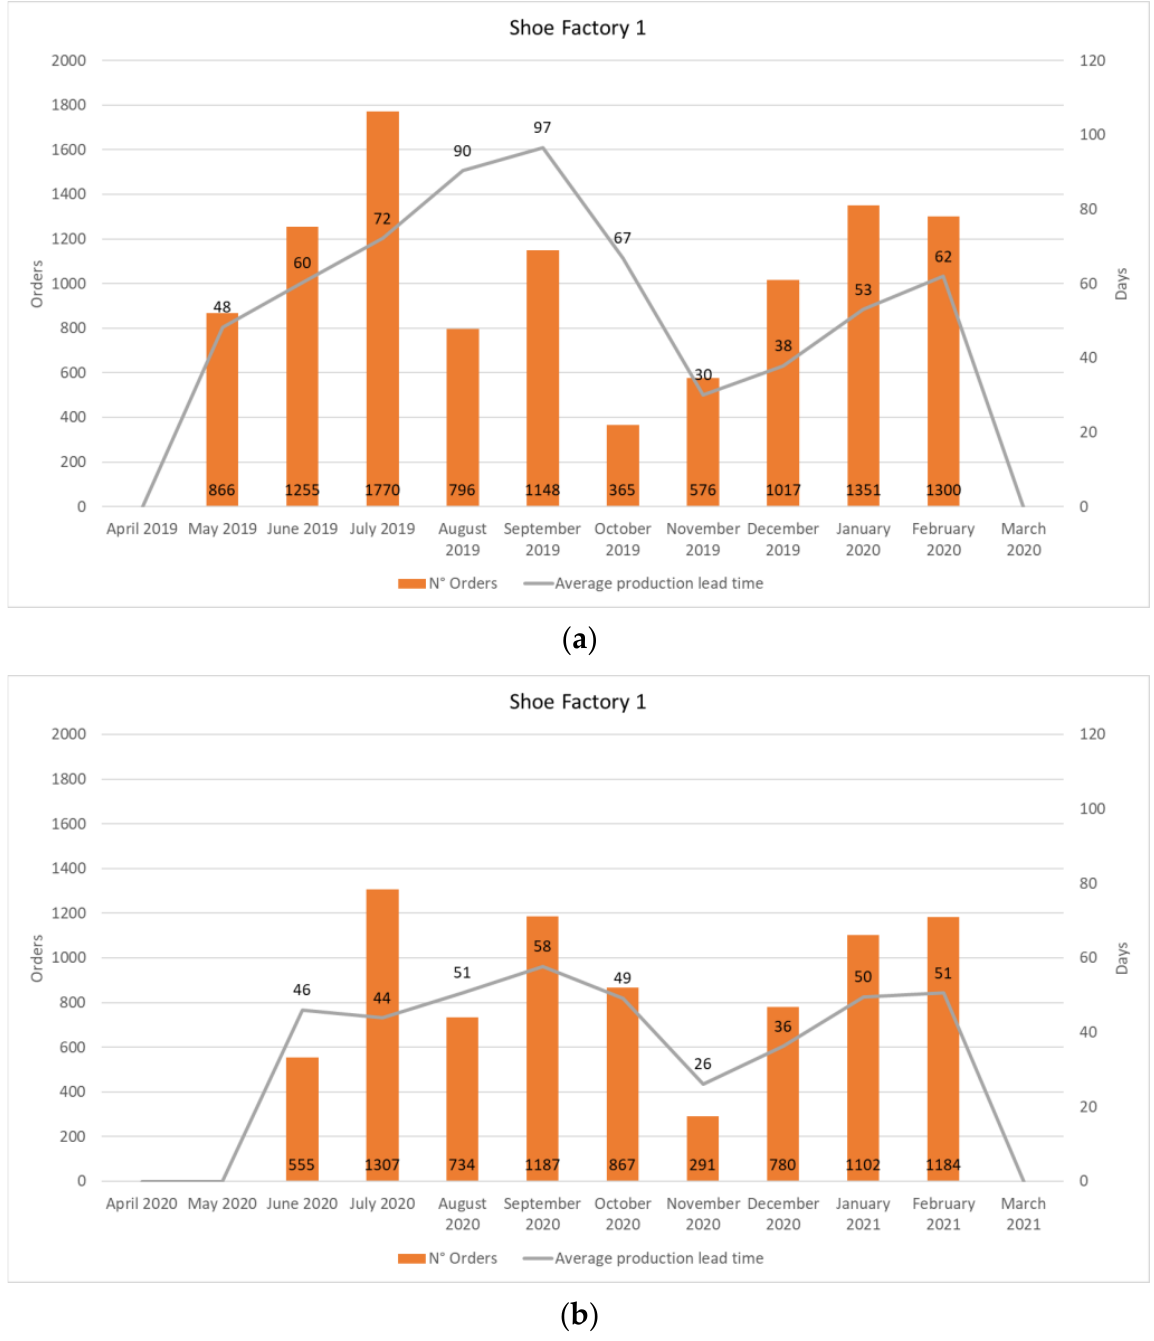
Figure 3. Shoe factories — seasonal N° of pairs, N° of orders, and average production lead time, considering AW19-SS20 seasons ( a ) and AW20-SS21 seasons ( b ).